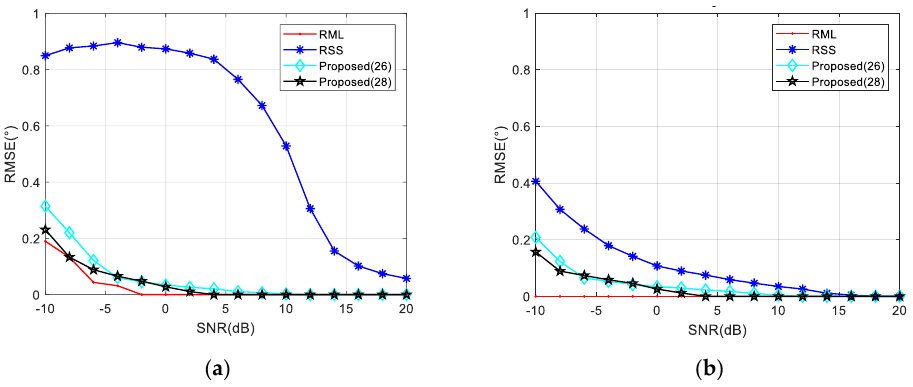
Figure 7. RMSE against input SNR in different elevation angles when 𝜌 = −0.95 . ( a ) 𝜃 = 1° and ( b ) 𝜃 = 5°.